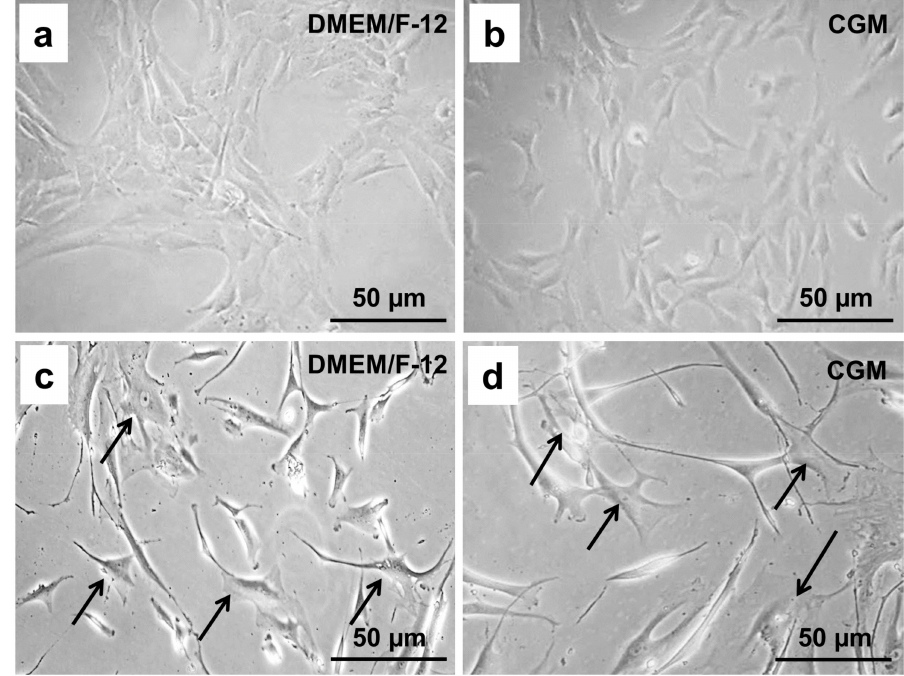
Figure 1. Morphological characteristics of human chondrocytes visualized by phase contrast microscopy. ( a ) Human chondrocytes cultivated in DMEM / F-12 medium after the first round of subculture. ( b ) Human chondrocytes cultivated in CGM after the first round of subculture. ( c ) Human chondrocytes cultivated in DMEM / F-12 medium after a third round of subculture. ( d ) Human chondrocytes cultivated in CGM after a third round of subculture. The arrows indicate the cell bodies of fibroblast-like single